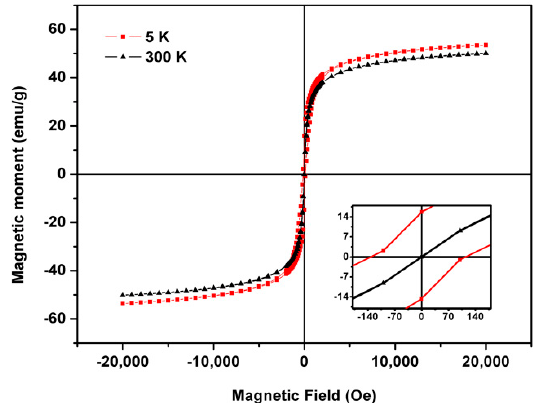
Figure 5. Magnetization hysteresis cycle of Ca 0.25 Mg 0.75 Fe 2 O 4 ferrite nanoparticles at 5 K and 300 K. Inset: enlargement of the hysteresis loop in the low field region. Table 1. Coercive field (H C ), maximum magnetization (M s ), remnant magnetization (M r ), and ratio